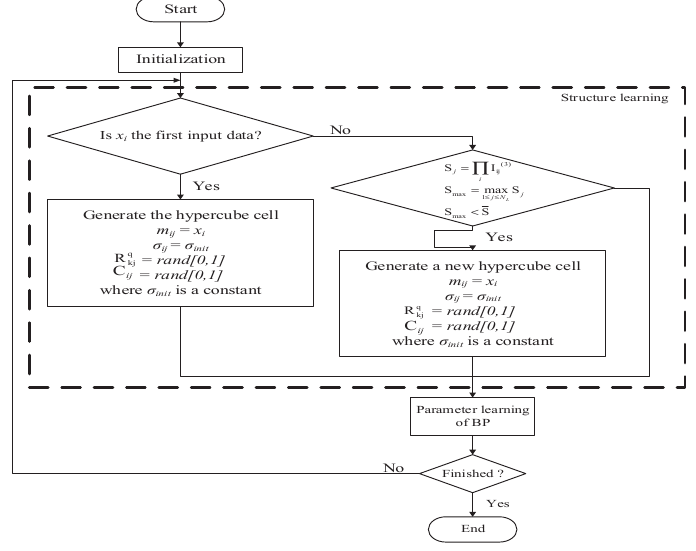
Figure 3. A flowchart of the proposed structure and parameter learning algorithm.